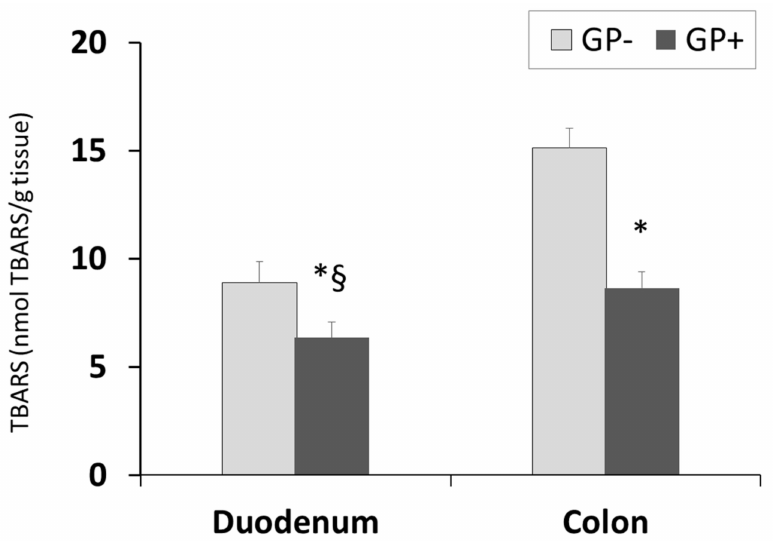
Figure 5. Lipid peroxidation (nmol TBARS/g tissue) as determined by the TBARS assay, in duodenum and colon samples (n = 10); * = statistically significant when GP − was compared with GP+, § = statistically significant when compared with colon GP+.